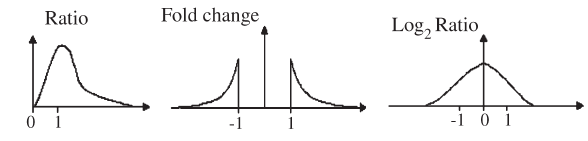
Figure 1 - Curves of the three ratio-based